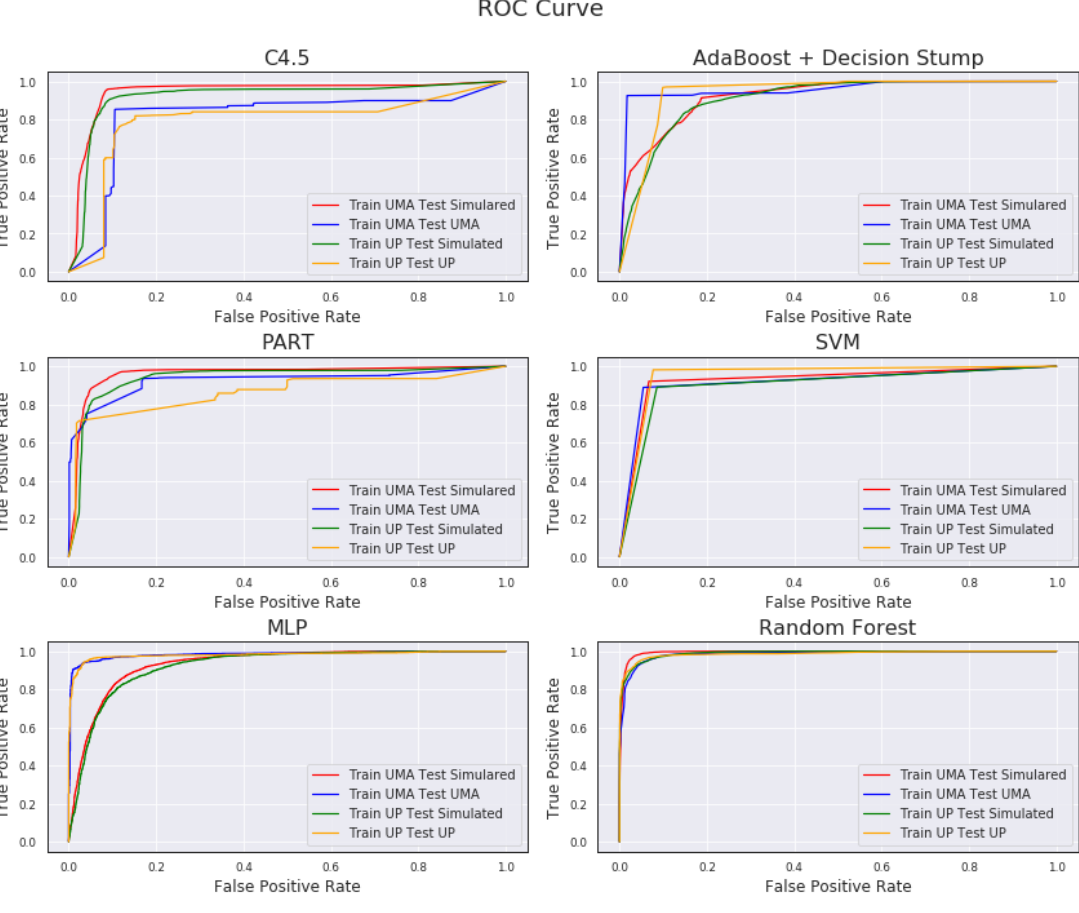
Figure 6. ROC curve comparing the performance of the ’fall’ class of each